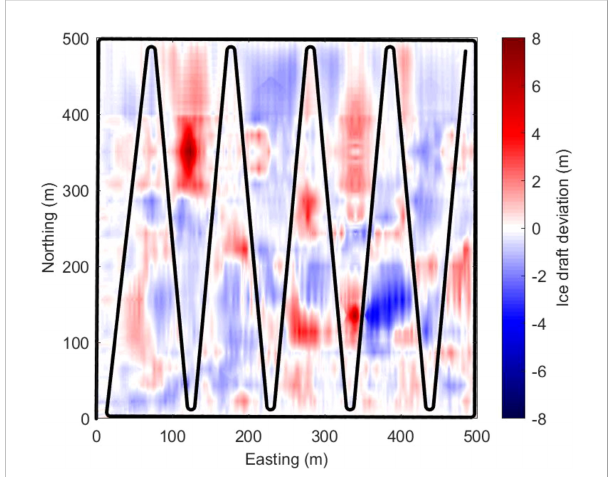
FIGURE 7 Deviation error between reconstructed and actual ice draft (Black solid track presents the predetermined trajectory for rough